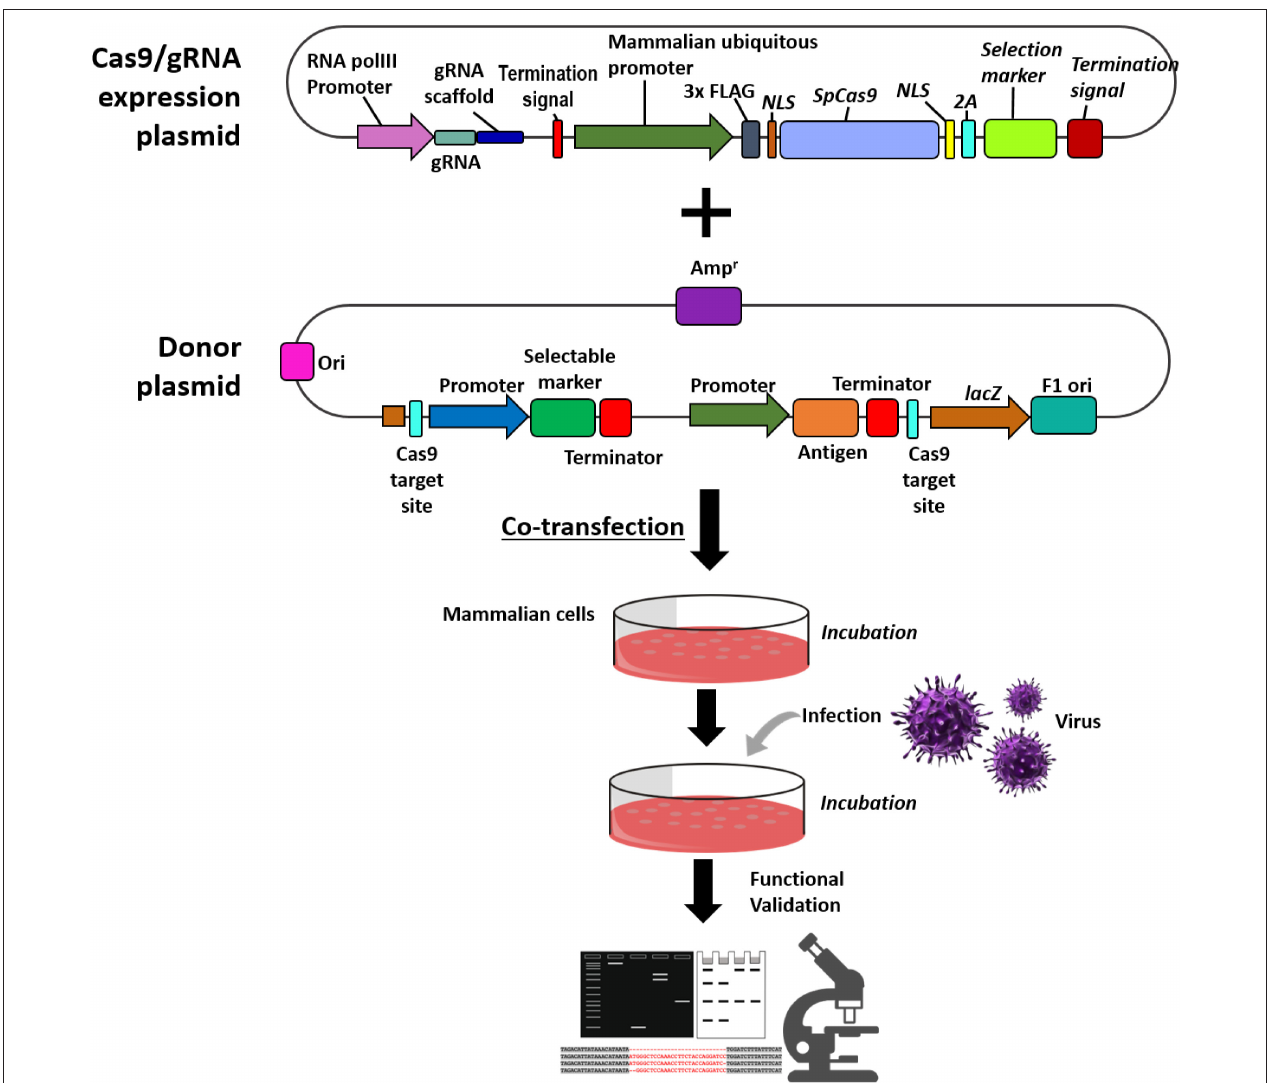
FIGURE 2 | Schematic on the generation of recombinant viral vector and functional validation. Steps for the co-transfection of the Cas9/gRNA expression cassette and donor plasmid to the mammalian cells, followed by infection of the virus of interest. Functional validation and characterization of the recombinant viral vector through western blot analysis, PCR amplification and